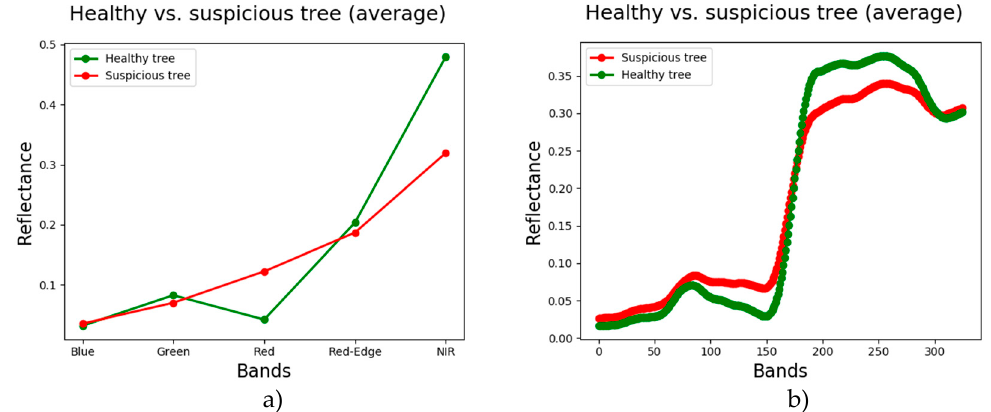
Figure 7. Illustration of spectral differences between healthy (green) and early infected (red) spectra: a) multispectral data; b) hyperspectral data.